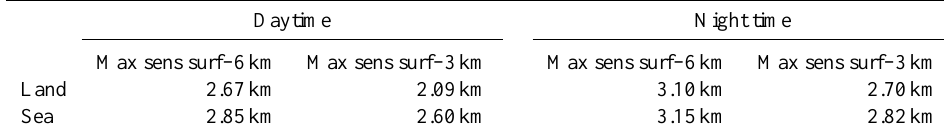
Table 3. Mean altitudes of the maximum of the integrated AK for the surface–6km TOC and surface–3km TOC for land/day, land/night, sea/day and sea/night pixels, calculated over the whole data set, on a 1h revisit time basis (Max sens: maximum